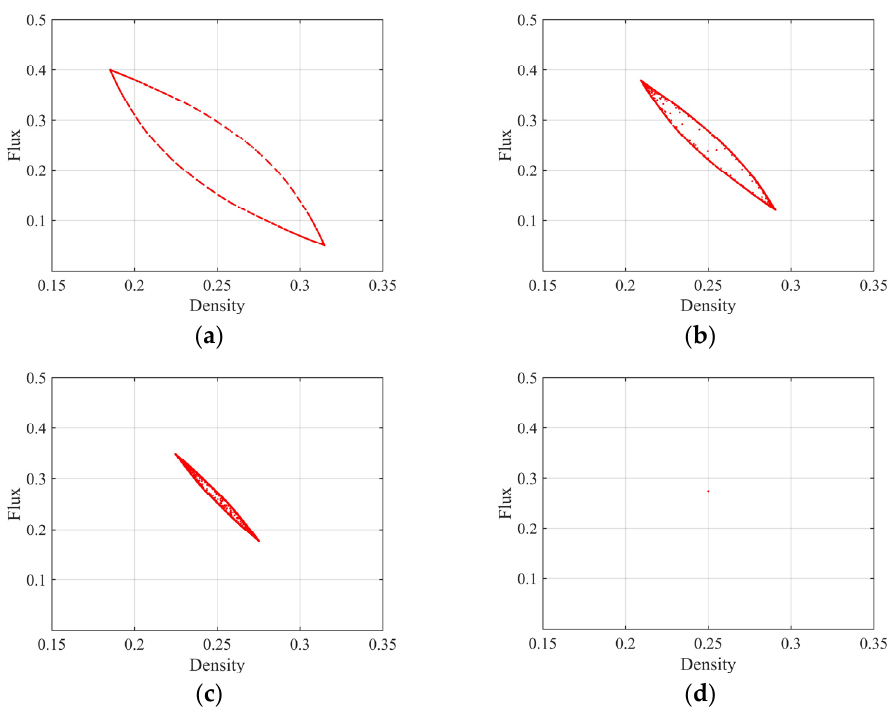
Figure 8. The hysteresis loops of traffic flux and density for different k . ( a ) k = 0, ( b ) k = 0.1,